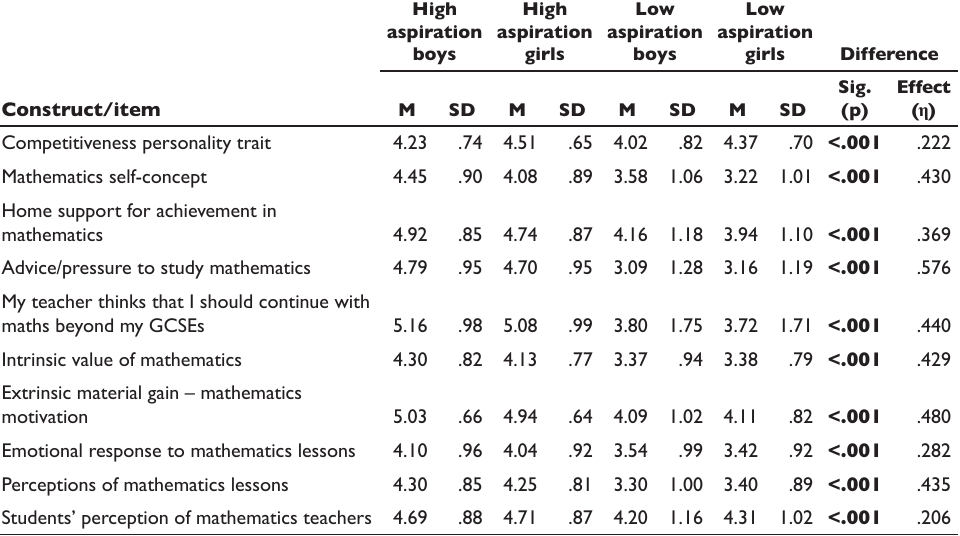
Table 2.1: UKyear8andyear10students:Girls’andboys’aspirationsinmathematicsandthe relationshipwithotherfactors